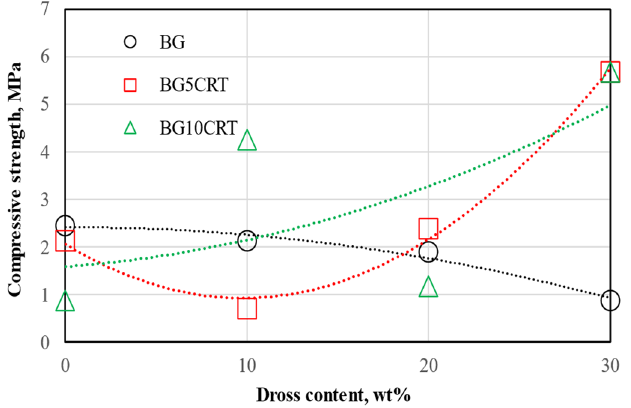
Figure 10. Compressive strength of foam